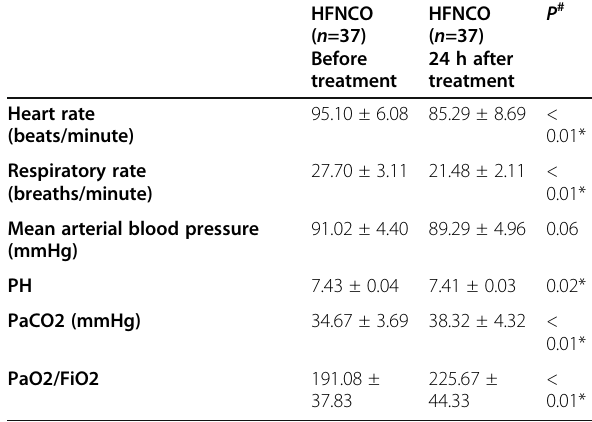
Table 4 Comparison between vital signs and arterial blood gases before and after treatment in patients using HFNCO